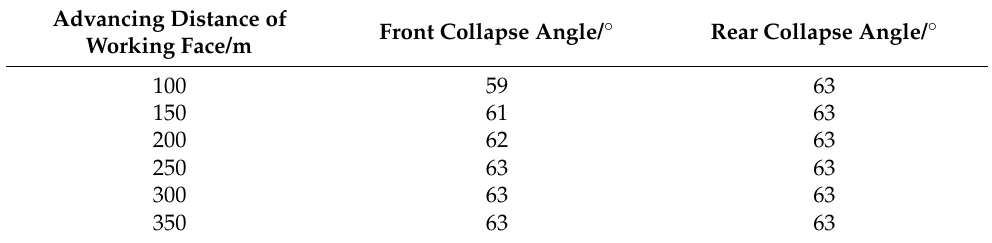
Table 3. Overlying strata caving angles with different advance distances under multi-aquifer.